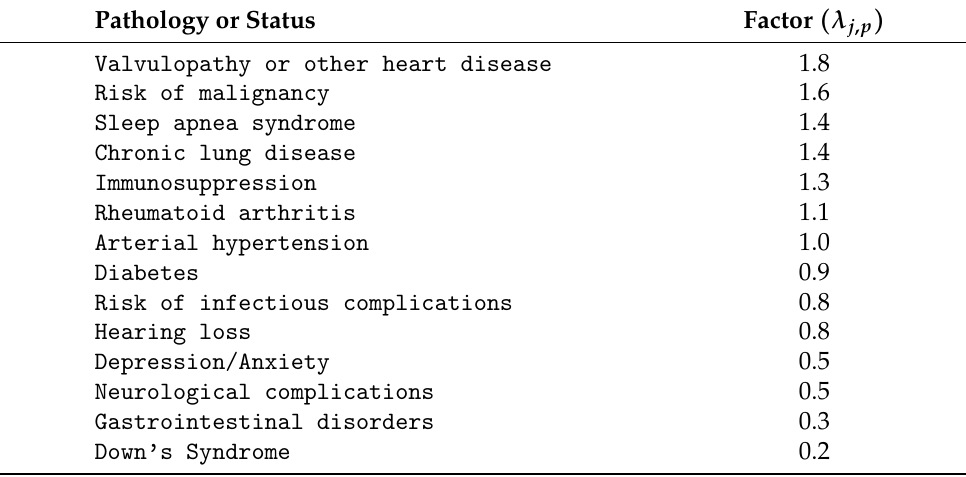
Table 5. Additional pathologies or conditions that ENT patients in SWL commonly present. The medical team agreed upon the group and the Factor of each one.